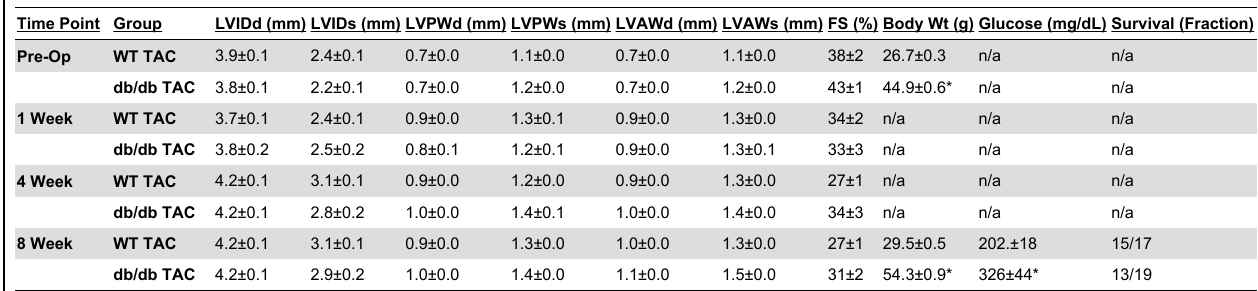
Table 3. Left ventricular diameters, wall thicknesses, and fractional shortening of db/db TAC group; additionally, body weight, blood glucose, and survival